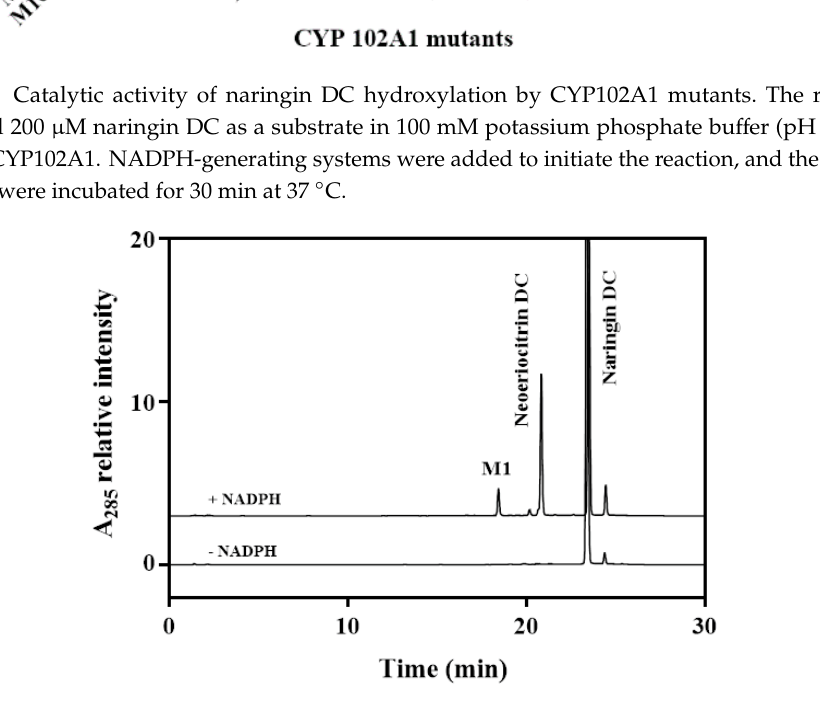
Figure 3. HPLC chromatogram of naringin DC and its products formed by CYP102A1 mutant M221. The peaks of reaction mixtures of HPLC chromatograms were identified by comparing their retention times with those of neoeriocitrin DC ( t R = 20.8 min) and naringin DC ( t R = 23.4 min). The retention time of M1 was 18.4